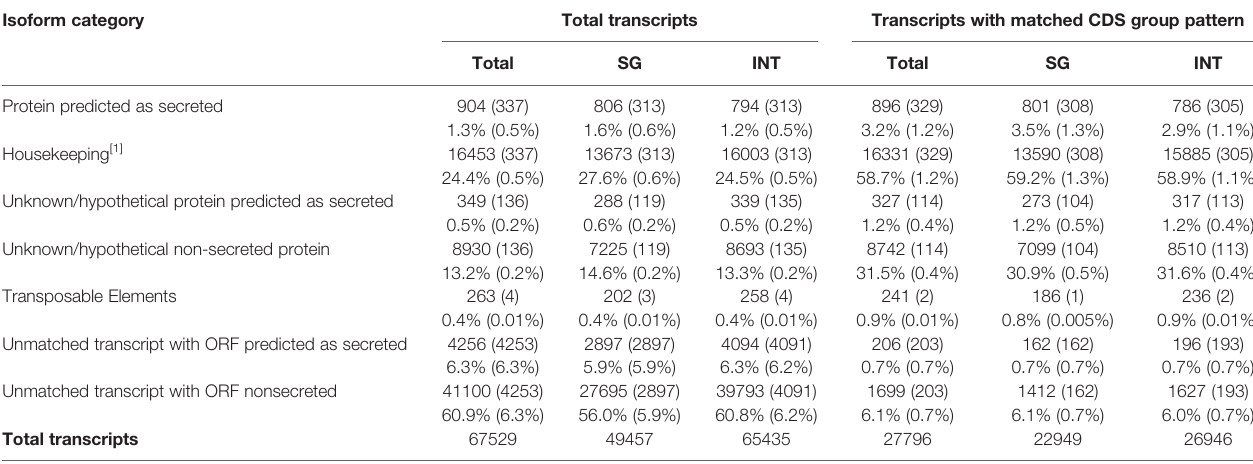
TABLE 1 | Classi fi cation of assembled and translatable transcripts into coding sequences (CDS). Isoform category